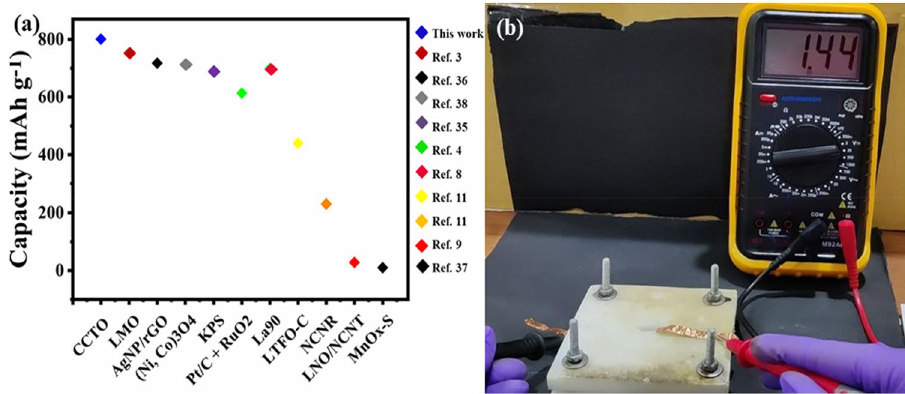
Figure 8. ( a ) Comparison of various zinc–air batteries with CCTO; ( b ) shows the potential of the designed solid-state zinc–air cell giving the OCV of 1.44